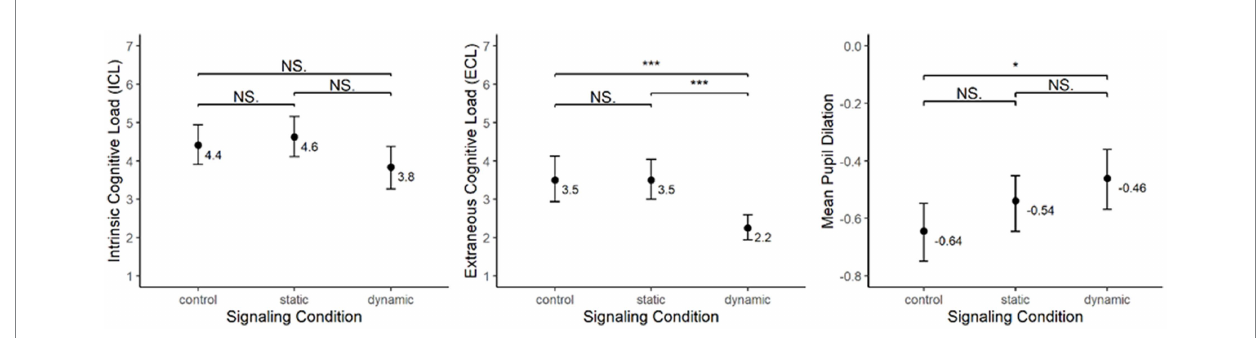
FIGURE 2 Means for intrinsic cognitive load (left), extraneous cognitive load (center), and pupil dilation (right) by signaling condition. Points indicate mean-values, error bars 95% confidence intervals. Results of pairwise comparisons are indicated by significance levels (NS. p > 0.05; * p < 0.05; ** p < 0.01; *** p <